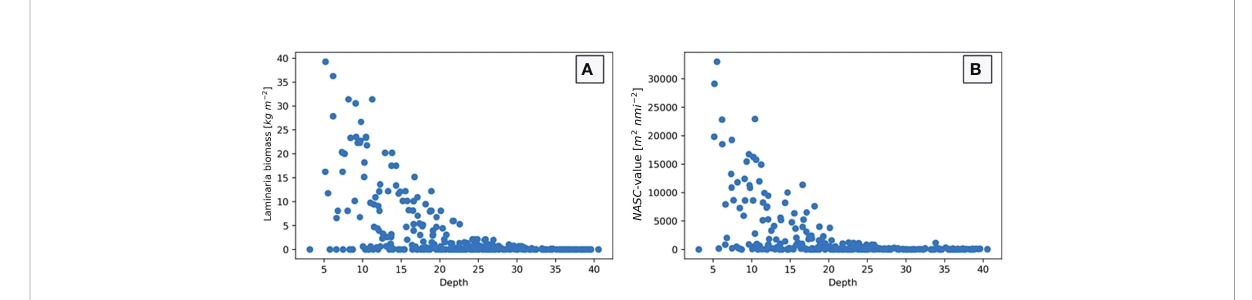
FIGURE 8 Biomass density estimate (A) and NASC-value (B) plotted with depth of each of the 298 stations in this study. The fi gures show a general decrease in biomass and backscatter strength as water depth increase, speci fi cally for depths deeper than 20-25 meters when both estimates drop close to zero.